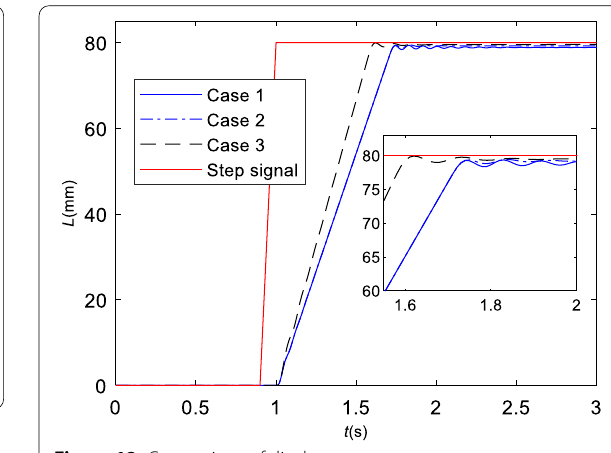
Figure 12 Comparison of displacement response